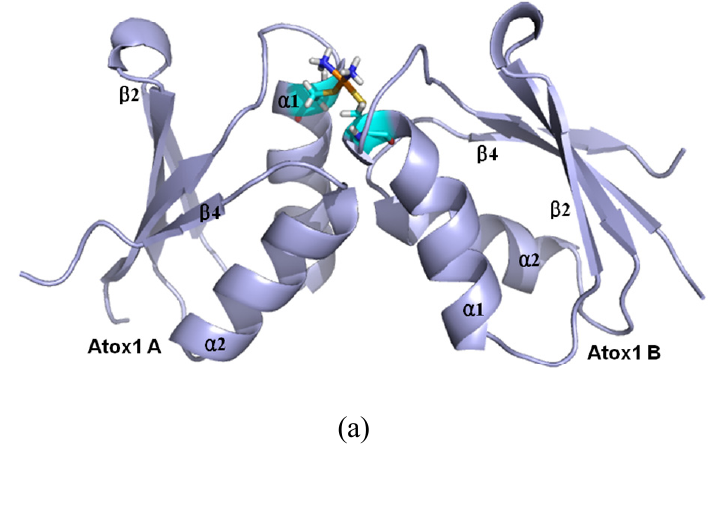
model; and ( c ) the TransPt + 2Atox1 model (Pt: orange; N: deep blue; C: cyan/magenta; S: yellow; O: red; H: